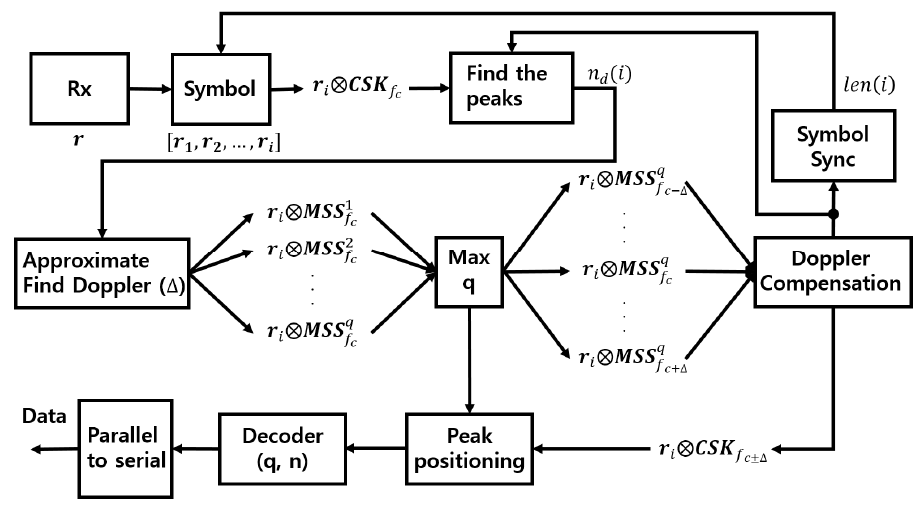
Figure 4. Block diagram of the proposed method.